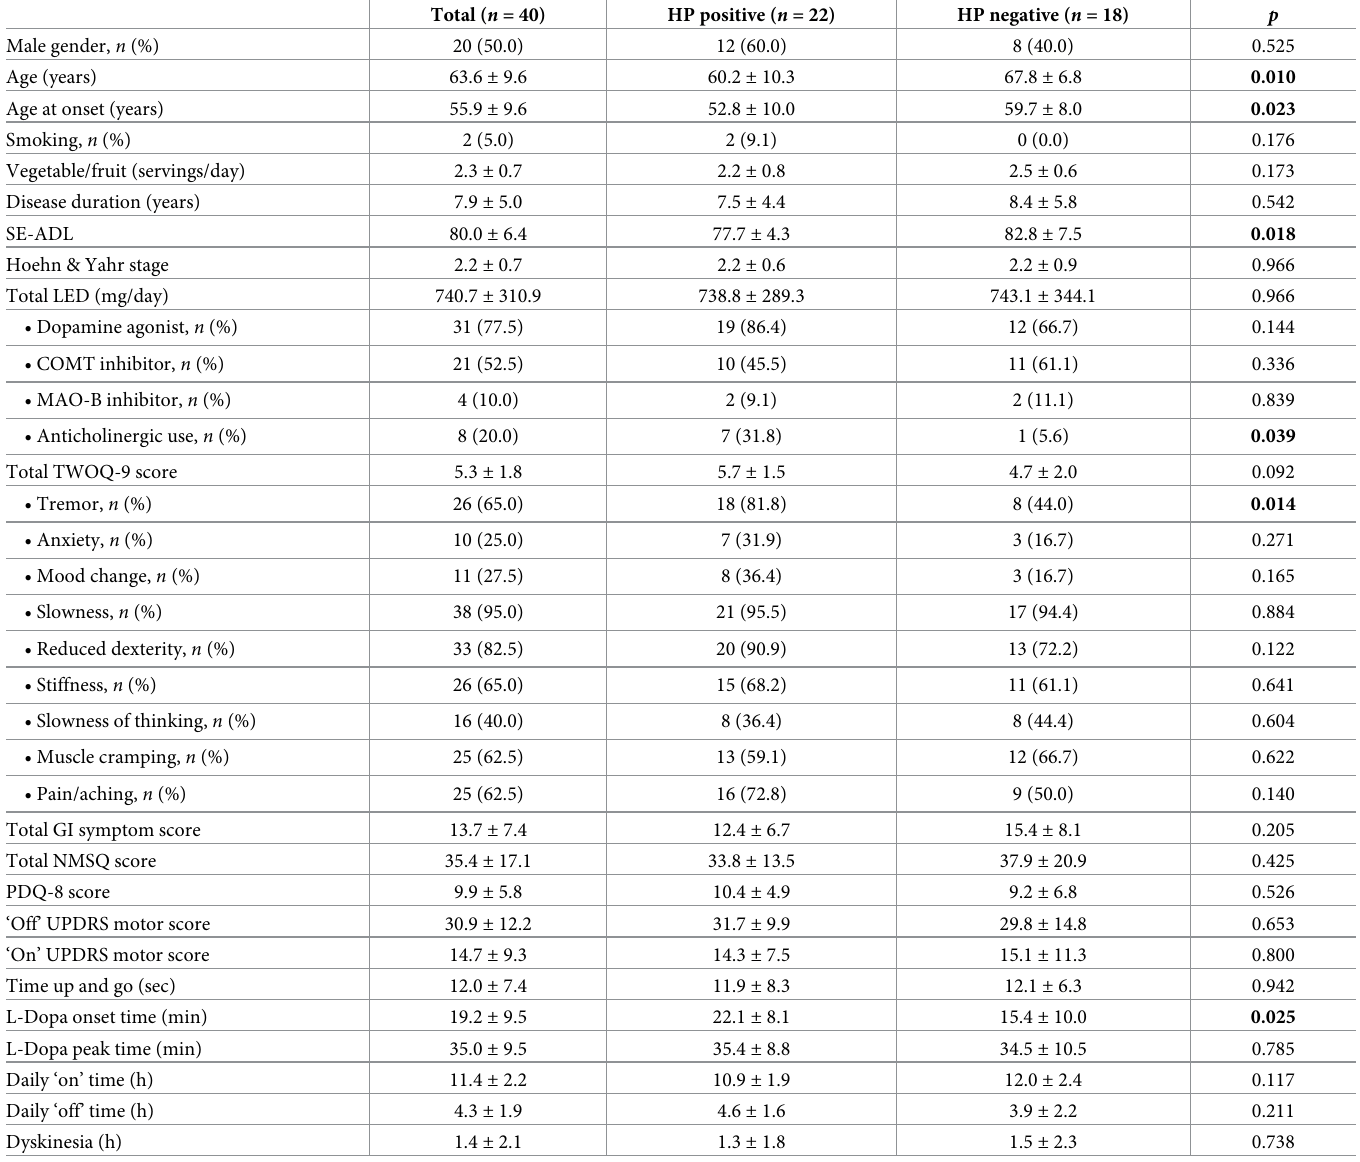
Table 1. General demographic data of the study